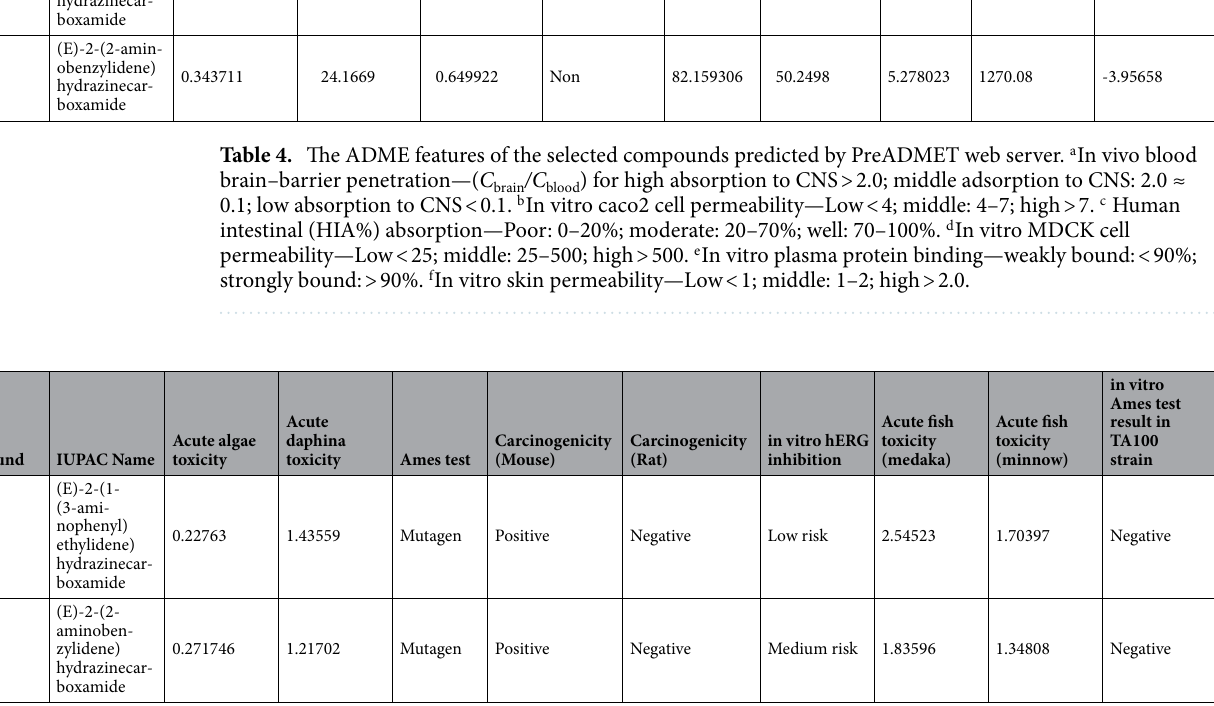
Table 5. The toxicity features of the selected compounds predicted by PreADMET web